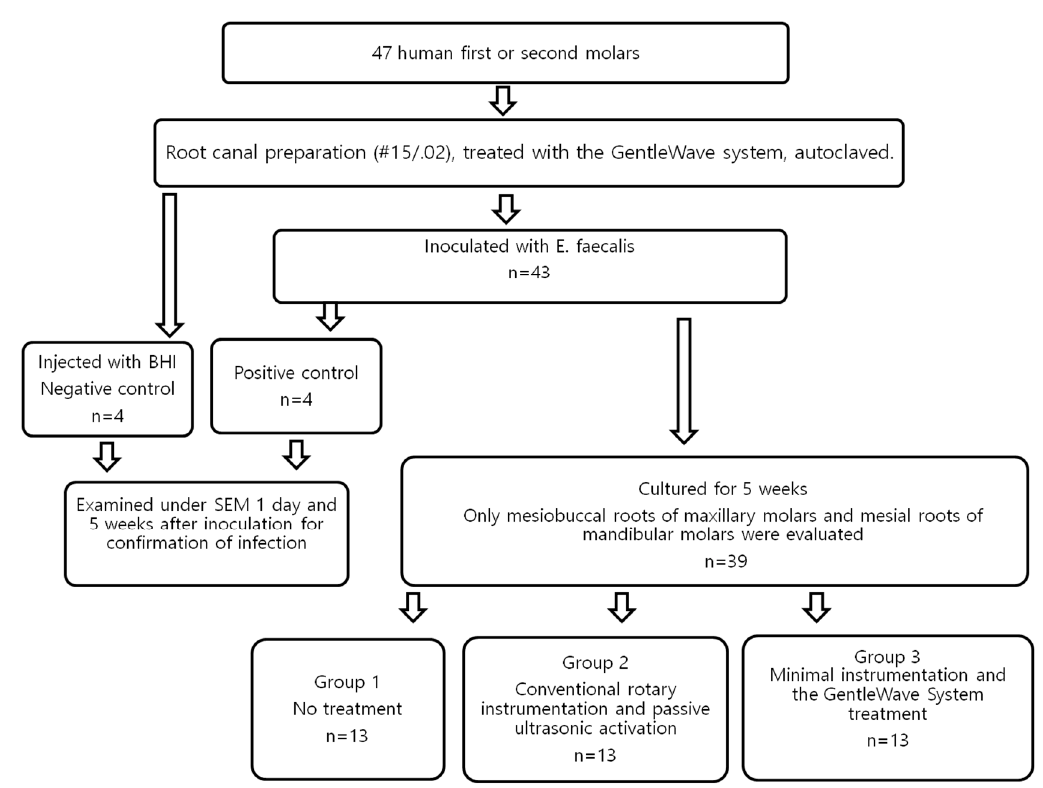
Figure 1. Flow diagram of all the treatment procedures.